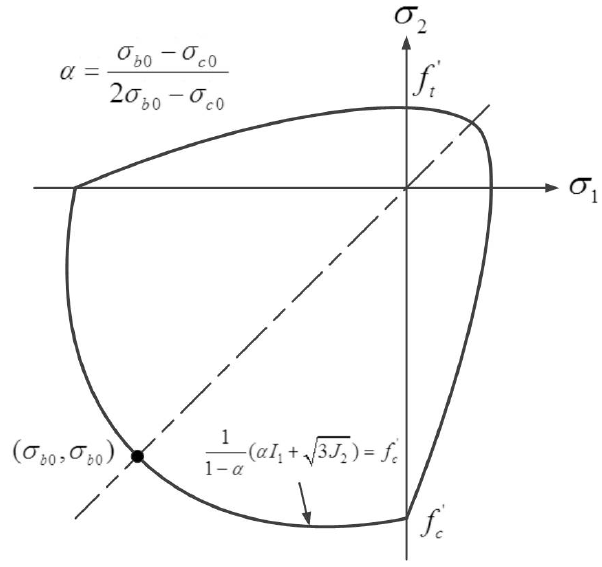
Figure 2. Biaxial concrete strength envelope (Lee and Fenves,